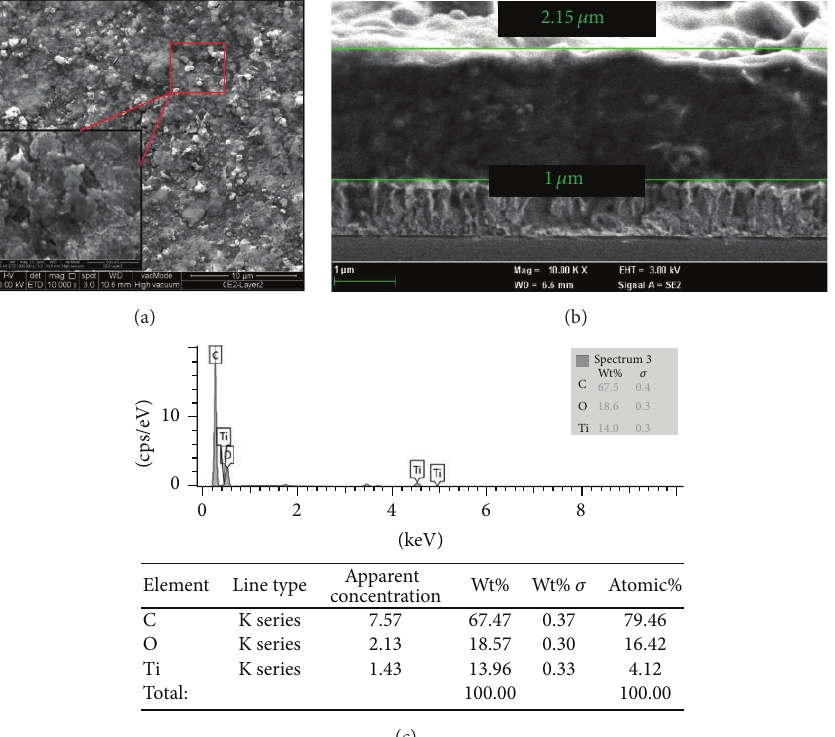
Figure 3: (a) Top view and (b) cross-sectional view of FESEM image for the HC film on FTO covered glass substrate (c) weight and atomic ratio of HC film estimated by EDX analysis.